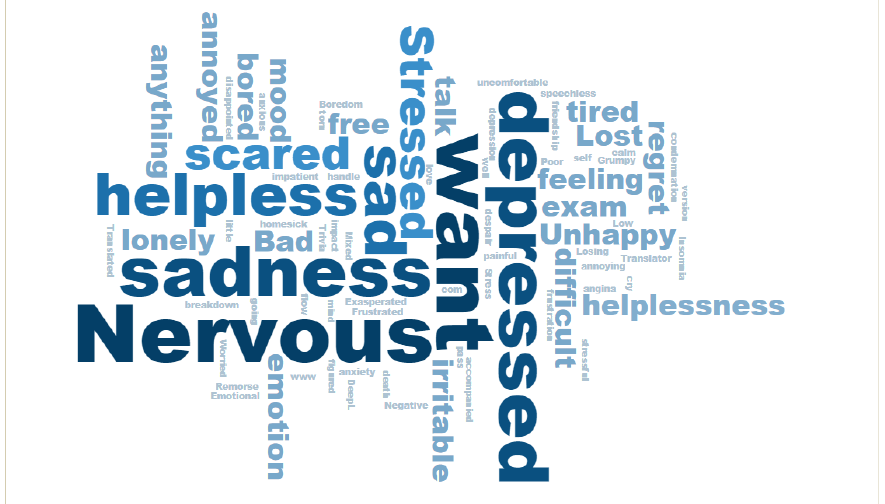
Figure 4. Profiles of negative emotions among participants.